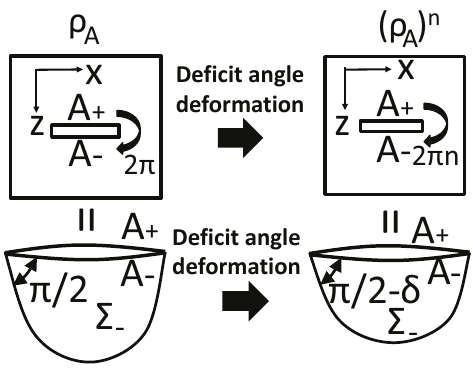
Figure 7 . The computation of entanglement entropy using the optimized reduced density